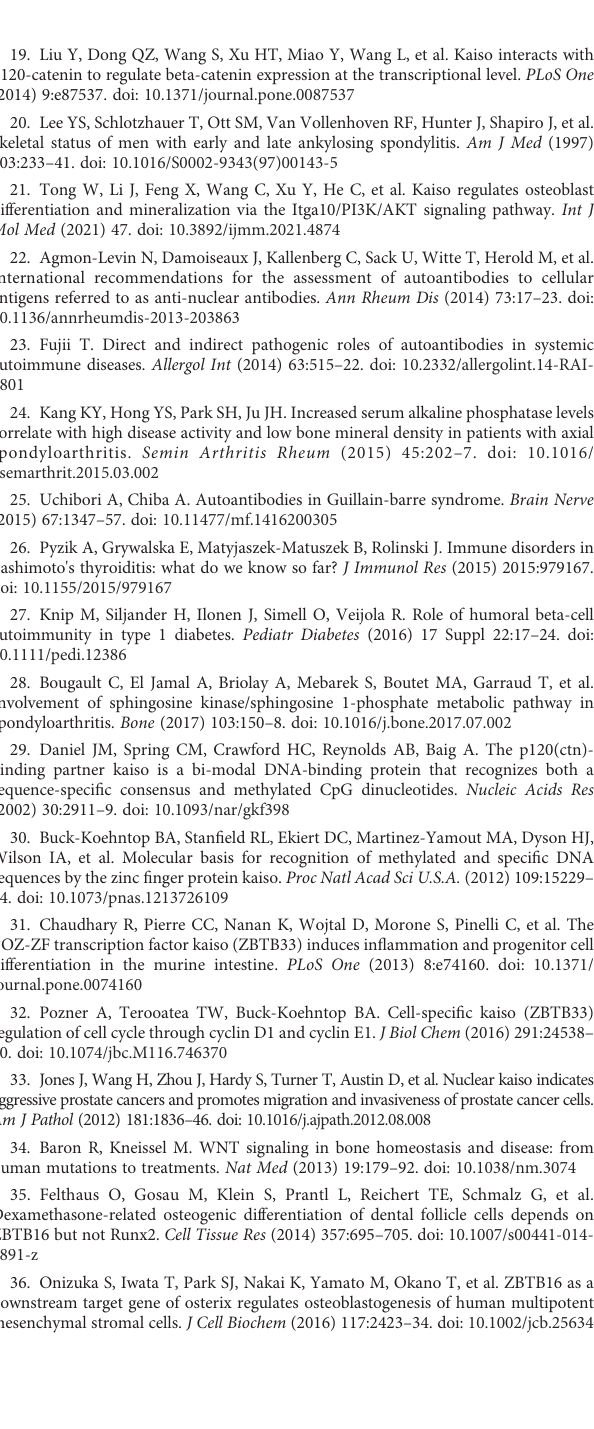
SUPPLEMENTARY FIGURE 1 Correlation between anti-Kaiso autoantibody levels, BASFI scores (A) , ESR (B) in patients with axSpA. SUPPLEMENTARY FIGURE 2 Correlation between anti-Kaiso autoantibody levels and serum ALP activity in patients with